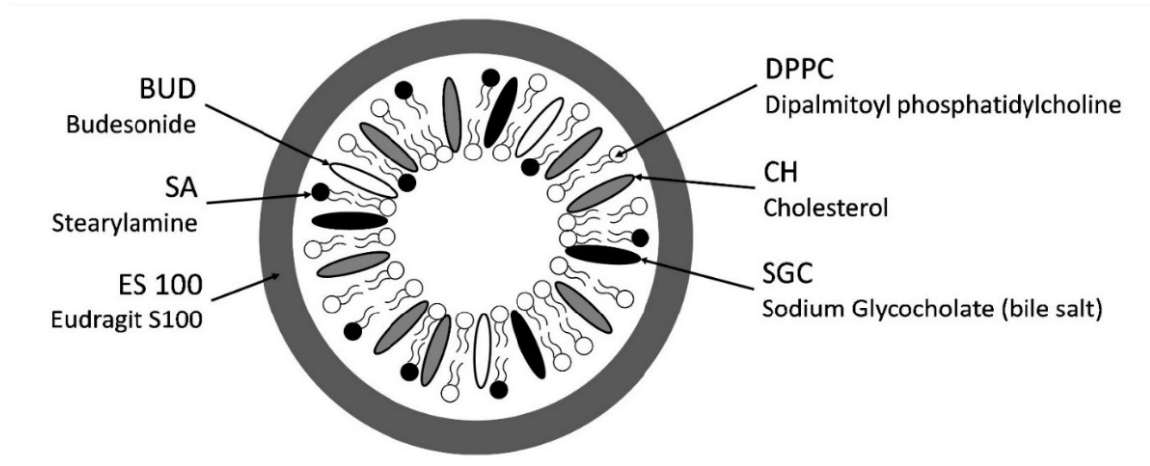
Figure 1. Schematic diagram for ES100-coated bile salt-containing liposomes.